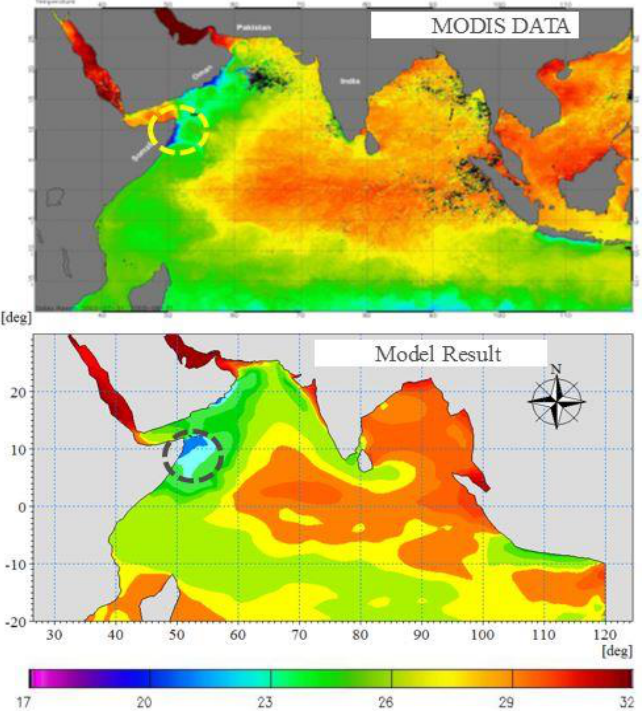
Figure 20. North Indian Ocean SST during summer monsoon; Modis Satellite data (top panel) and model results (bottom